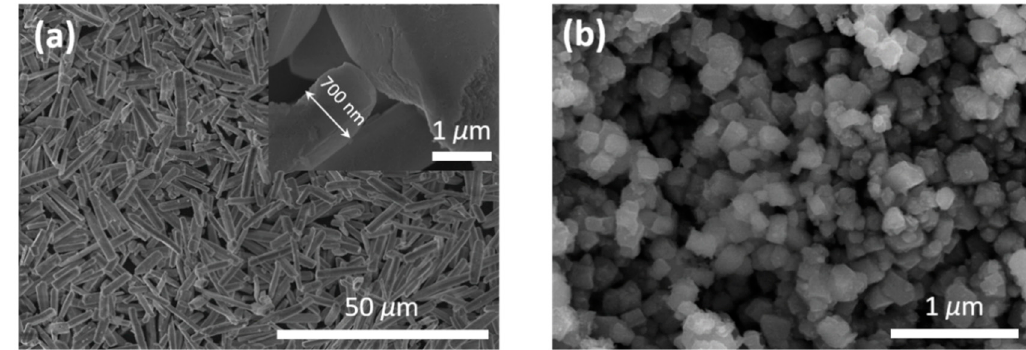
Figure 1. SEM images of ( a ) β -Ga 2 O 3 NRs. Inset: enlarged SEM image of the β -Ga 2 O 3 NRs, and ( b ) β -Ga 2 O 3 NPs.